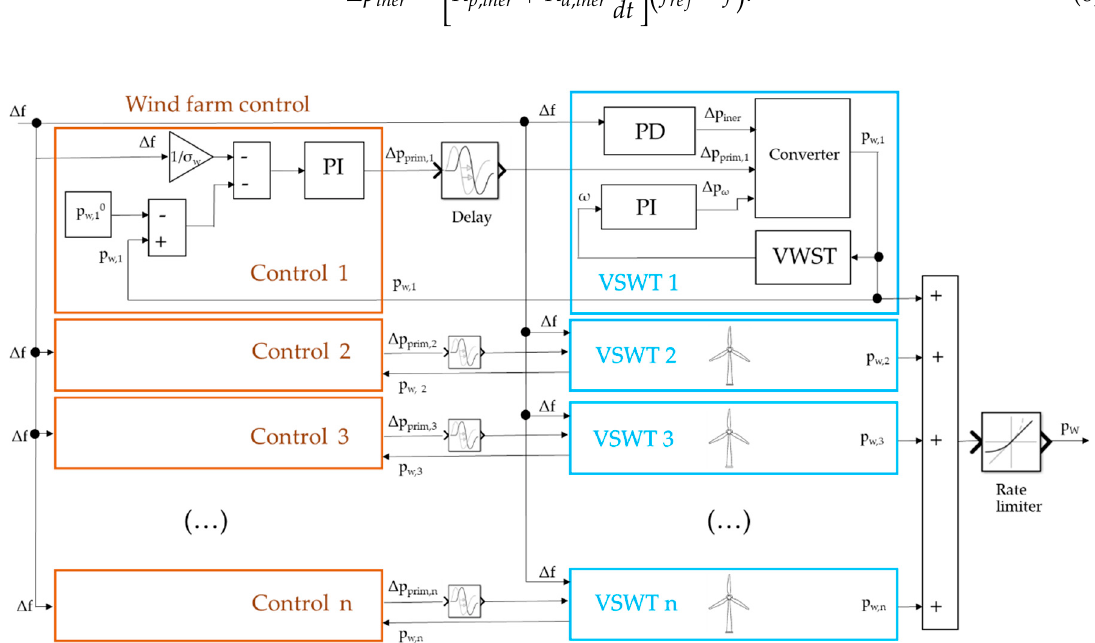
Figure 3. Frequency control scheme of wind farm and variable speed wind turbines.